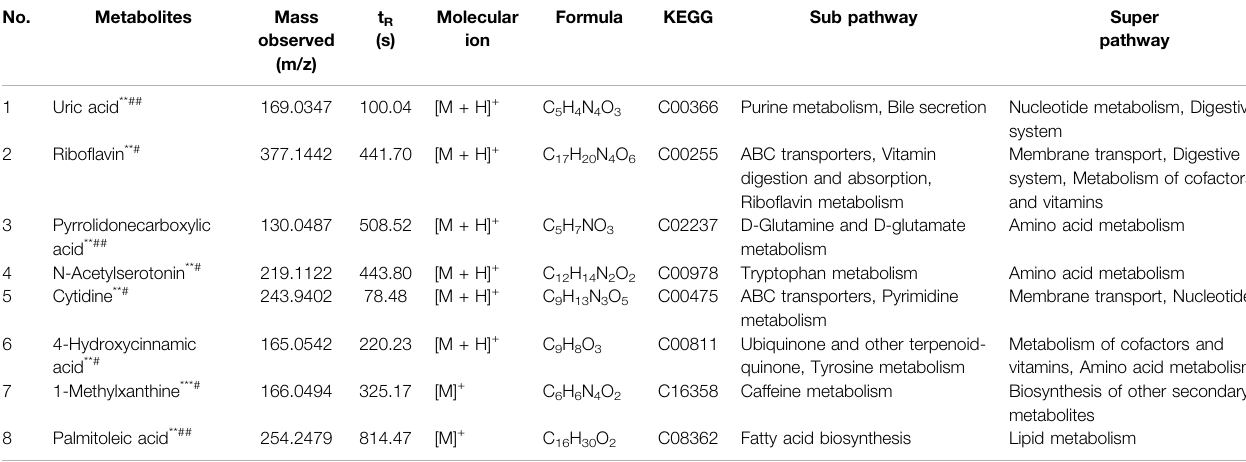
TABLE 2 | Characterization of differential metabolites and metabolic pathways in SHL medium-dose group.